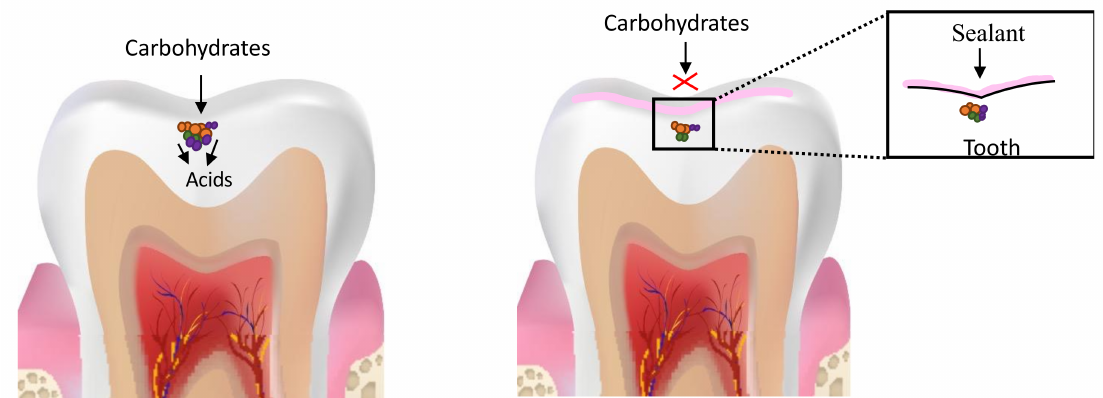
Figure 2. Schematic representation of caries arrest by sealant application. Sealant application deprives the biofilm within the carious lesion of nutrient supply, resulting in a reduction in the number of viable bacteria within the lesion, leading to the formation of a less virulent and less diverse biofilm, slowing/arresting caries